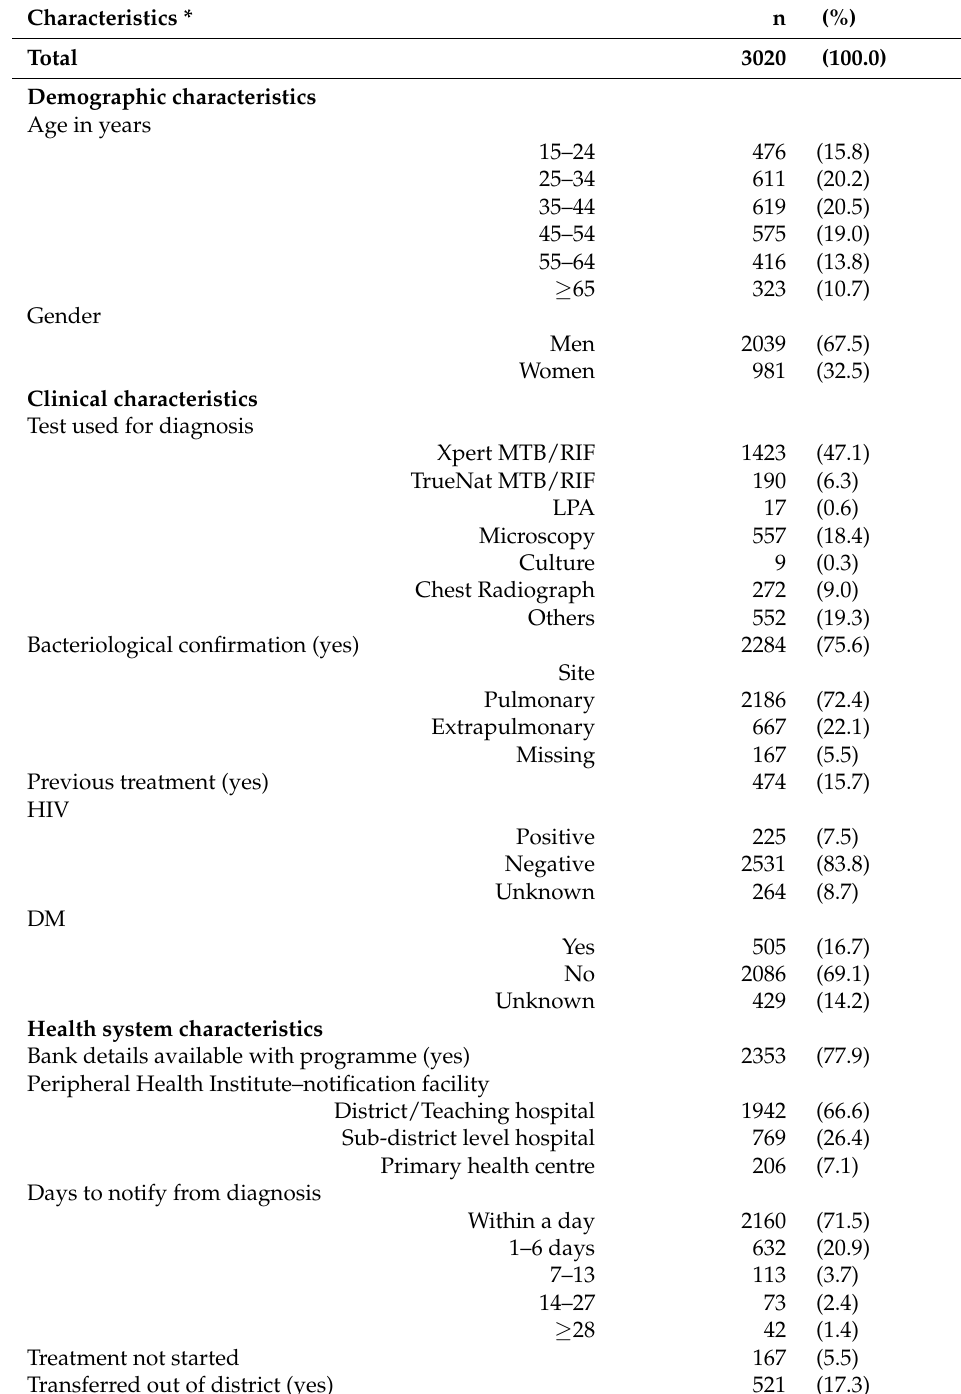
Table 1. Baseline characteristics of adults ( ≥ 15 years) with TB (without known drug-resistant disease at diagnosis) notified from public health facilities of 16 districts in Karnataka, India, 15 October to